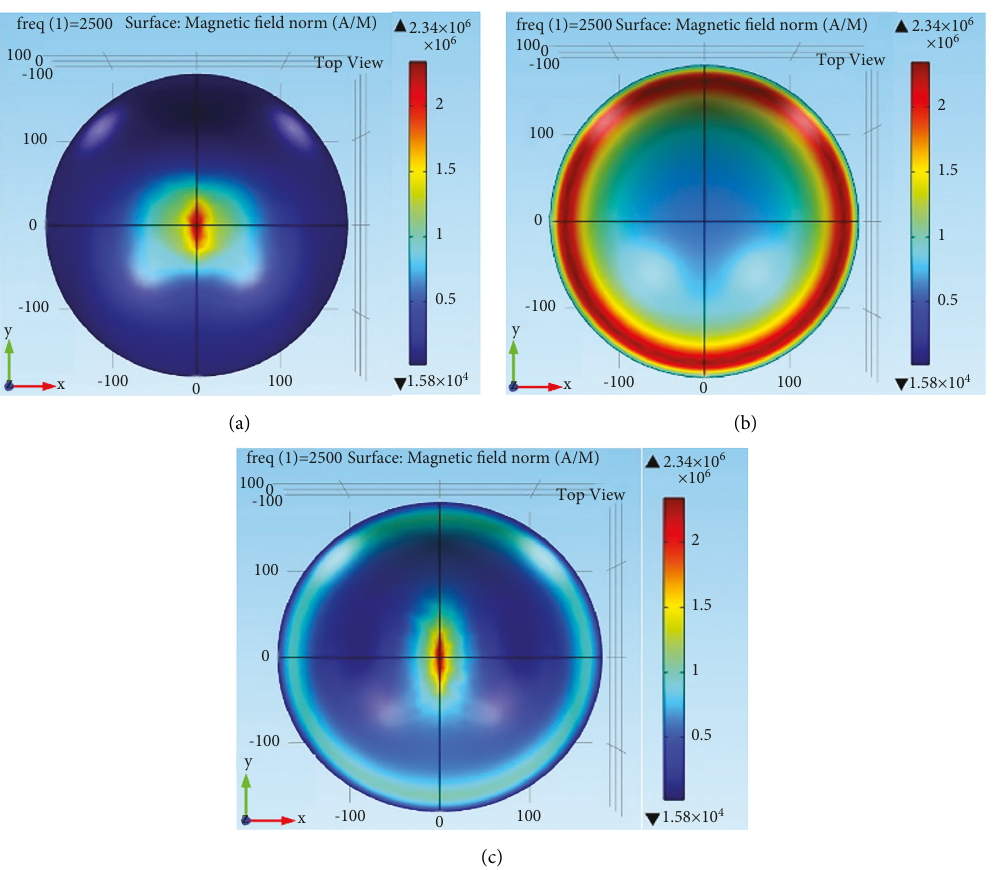
Figure 3: Magnetic field distribution of coils. (a) V coil, (b) Halo coil, and (c) HVA